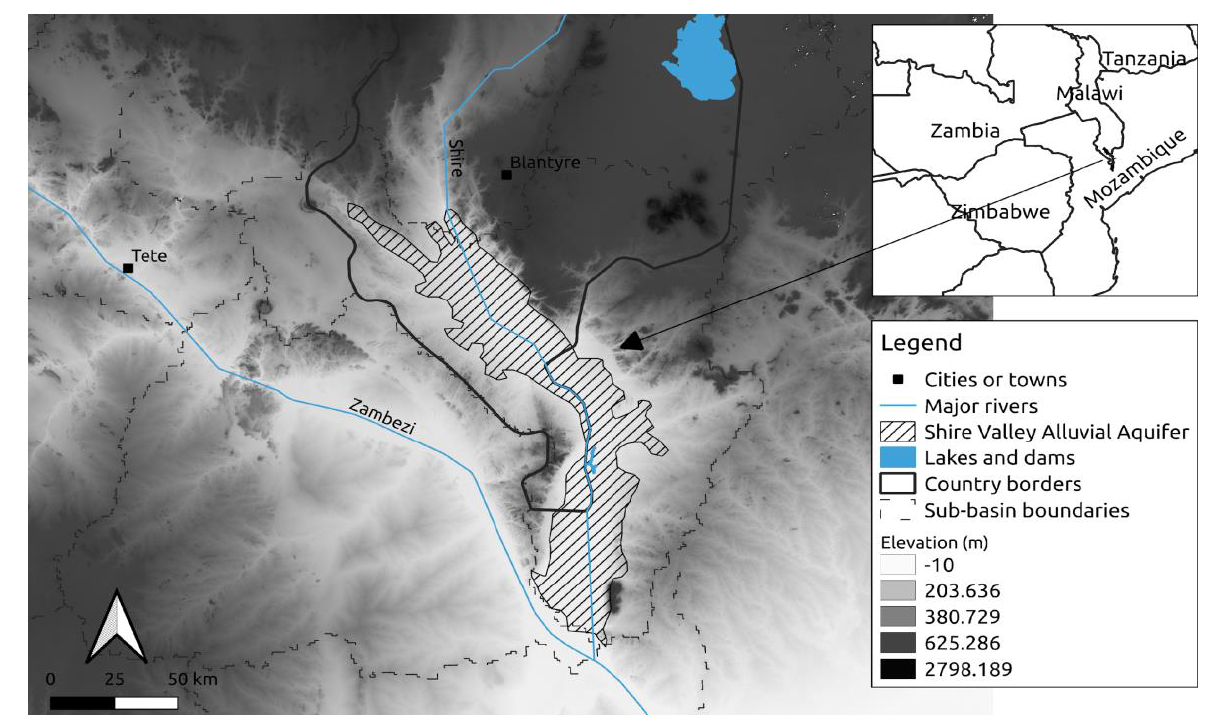
Figure 1. Map showing the location of the Shire Valley Alluvial Aquifer.